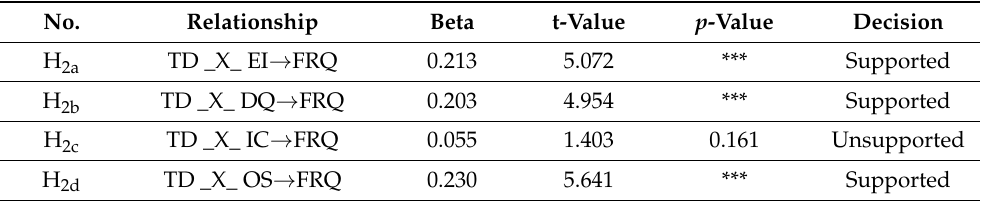
Table 4. The moderating role of transparency and disclosure on creative accounting and financial reporting